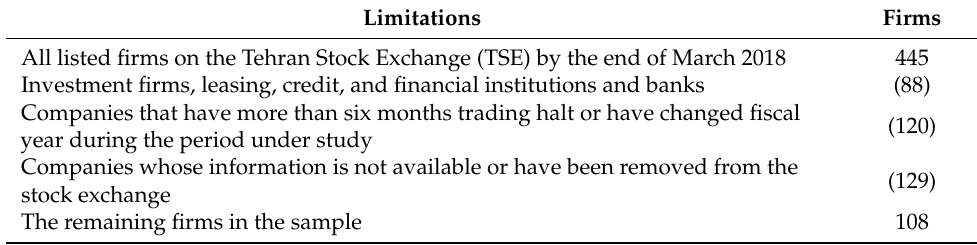
Table 1. The study